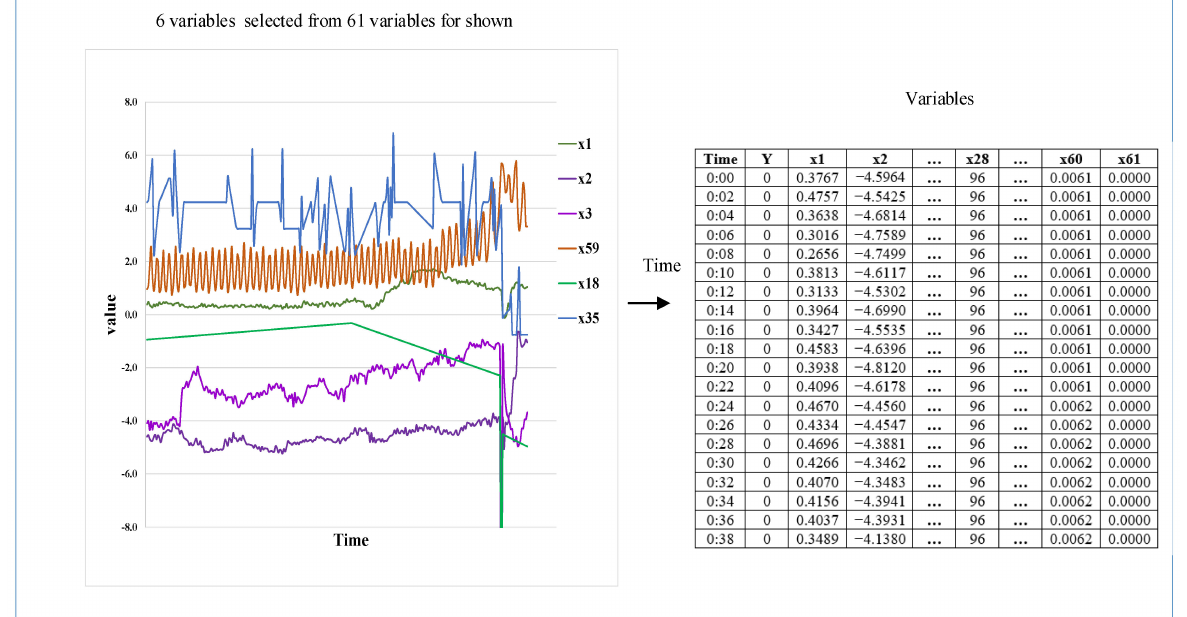
Figure 1. Original multi-sensor stream data from paper manufacturing processes.